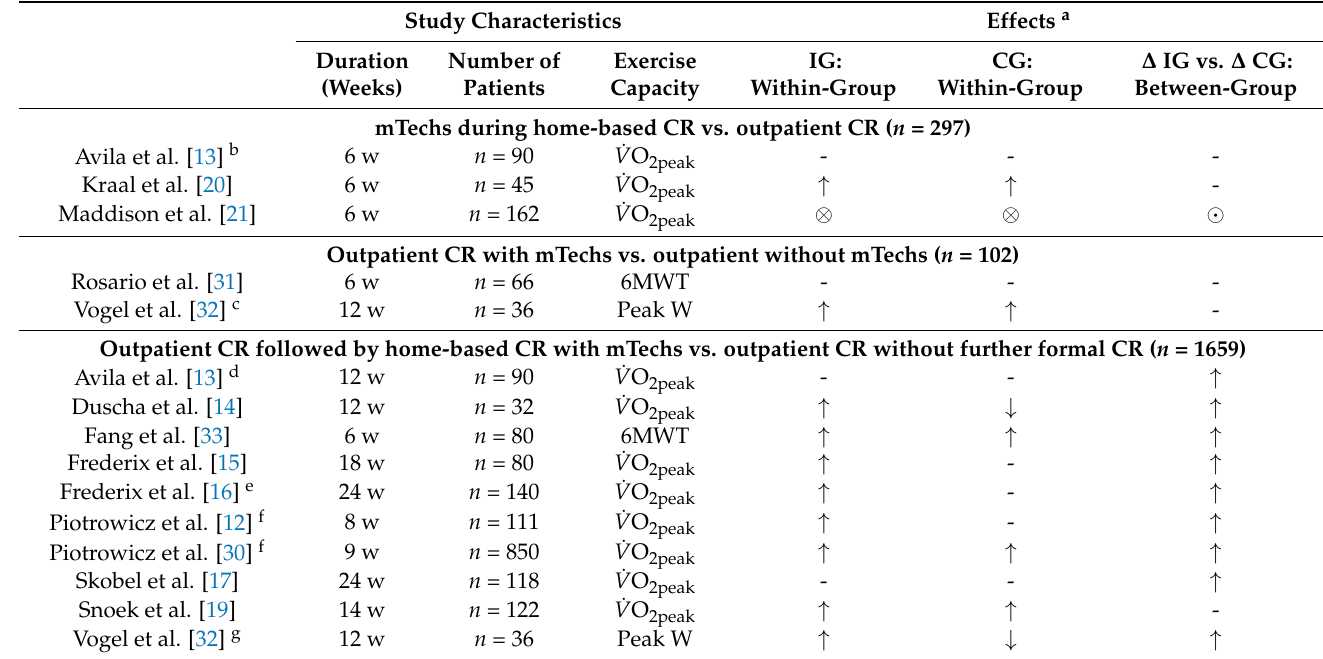
Table 2. Effects on exercise